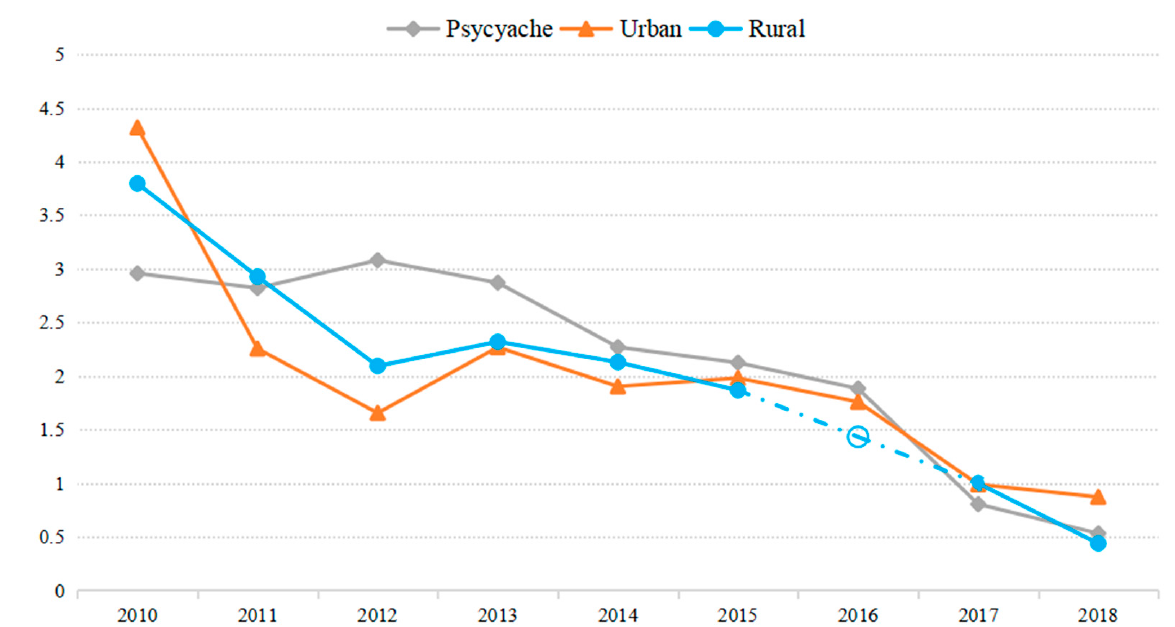
Figure 2. Trends of suicidal ideation risk on Weibo and social suicide rate, 2010–2018. Urban and Rural represent the suicide rate of urban or rural in China. Data are standardized by Z-score. The 2016 rural suicide rate was replaced by the before and after year (2015 and 2017) average value due to missing variables.